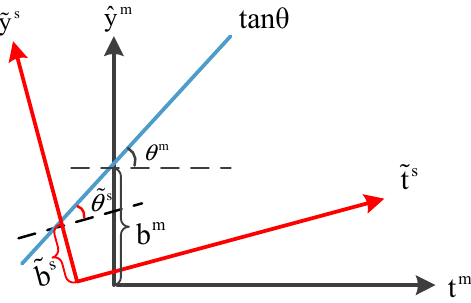
Figure 13. Theory of CTAI. tan θ is the coefficient between the feature vector and the predicted values. The angles and deviations observed under different instruments are different. We correct the predicted value of the slave instrument with the rotation and translation of affine transformation.